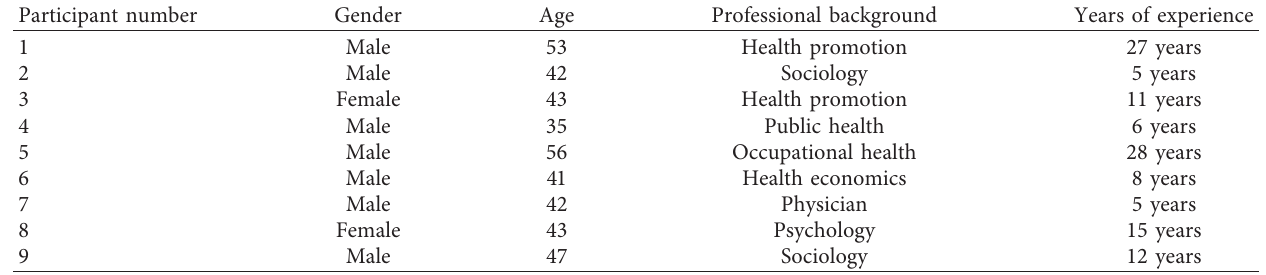
Table 1: Demographic data of interview participants.